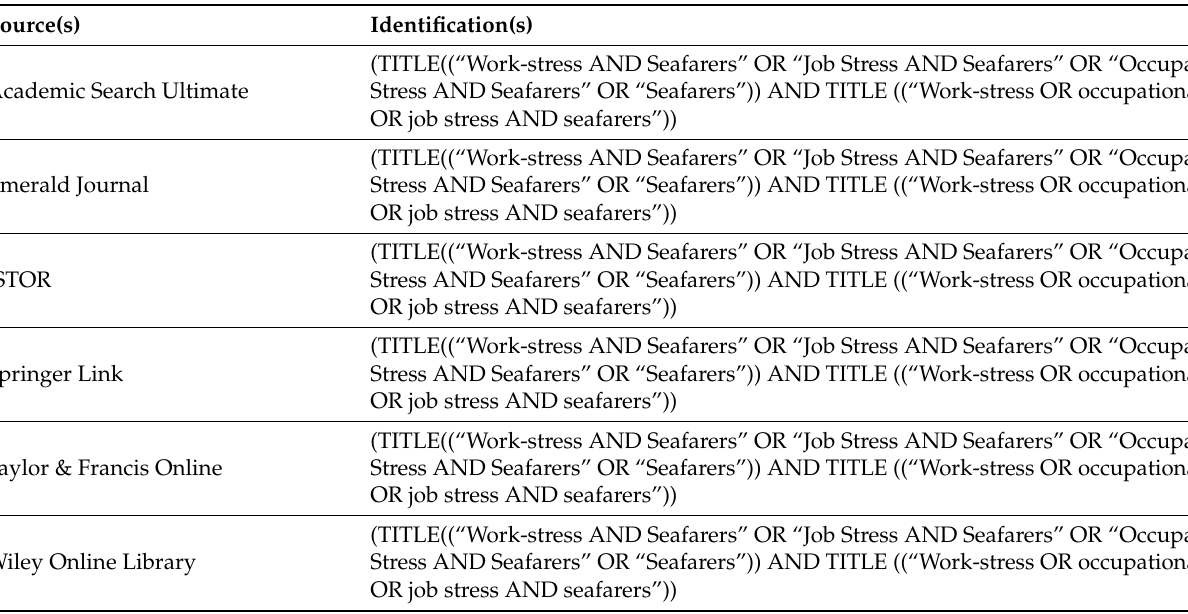
Table 1. The summary of the search